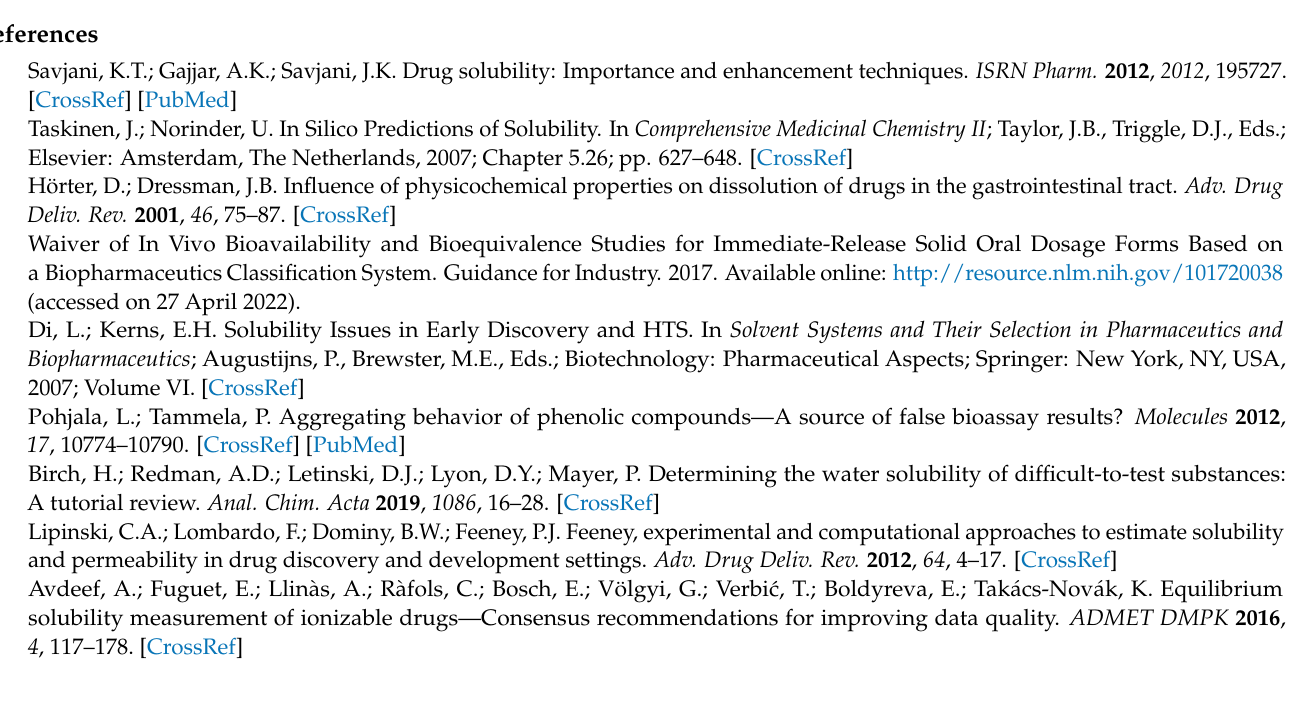
Table S2: Data for model M2. Table S3: Data for model M3. Table S4: Data for model